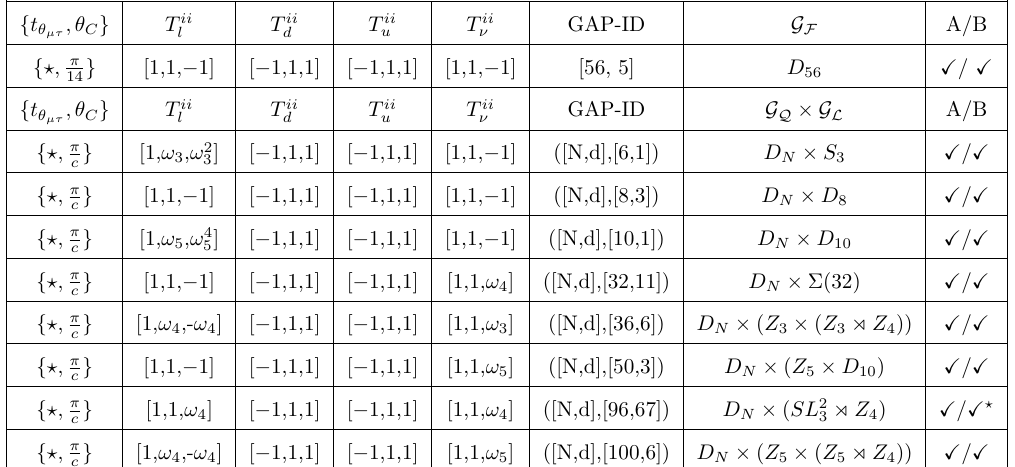
Table 3 . Flavour symmetries controlling (cid:21) [ e 3 X ] f 28 ; 30 g for all leptoquarks in Pattern A, N = 14 for (cid:1) ( (cid:22) )